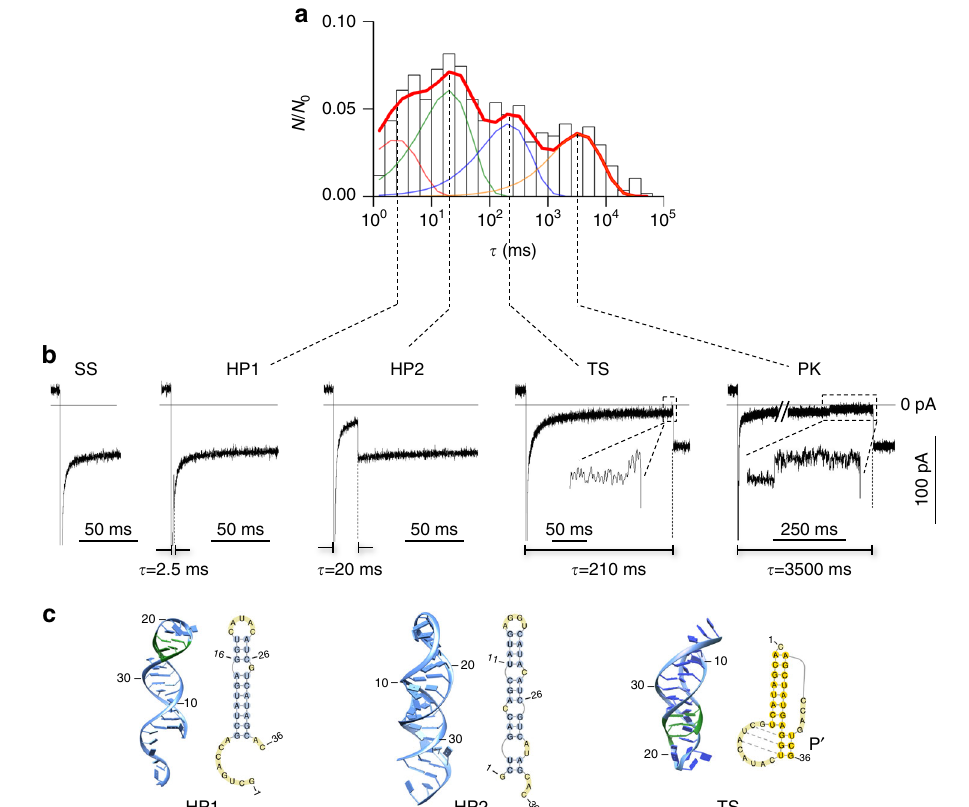
Fig. 3 Detection of intermediate folding states. a Histogram showing the distribution of unfolding durations of various folding states ( N 0 = 578). The x -axis is the time with bin width in the log scale. The y -axis is N 0 / N , where N 0 is the total number of events in the histogram and N is the number of events within each bin (log time). N / N 0 represents the fractional population for each bin, and the sum of N / N 0 for all bins, i.e., the area of the histogram, is normalized to “ 1 ” . After fi tting, the area covered by each component is the fractional population of the corresponding structure (Fig. 4). In this histogram, the unfolding duration of each RNA event was determined under the +120 mV/ t fold = 10 s/ − 60 mV protocol. Four components at 2.5 ms, 20 ms, 210 ms, and 3500 ms were identi fi ed in the distribution (Methods). Each component corresponds to a folding state. b Representative nanopore current signatures for the four folding states identi fi ed from the unfolding duration distribution in panel a. The longest component (3500 ms) is for the pseudoknot (PK). The 2.5 ms, 20 ms, and 210 ms components are intermediate states. The two insets clearly show the two-level conductance patterns, TS and PK, which are distinct from the single-level patterns for the other intermediate states, HP1 and HP2. In addition, the signature of the open pore current (without block) for single- stranded RNA (SS) is shown. c Structures observed in the simulation that correspond to the three intermediate folding states identi fi ed in the